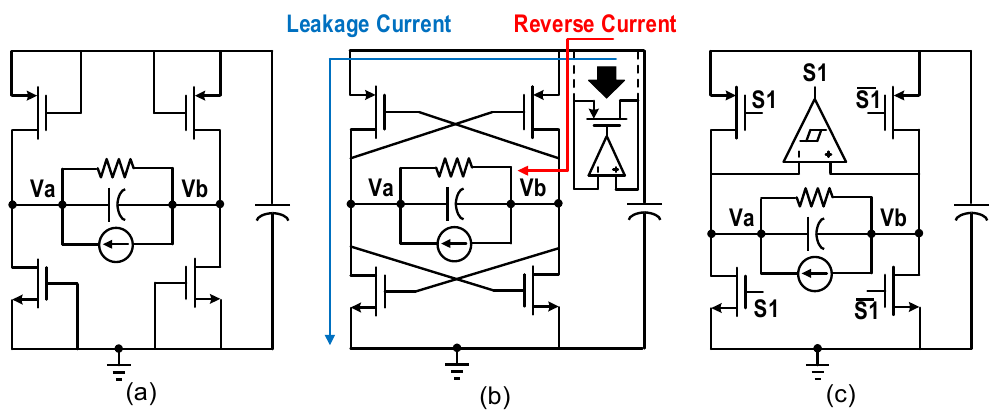
Figure 7. Structure diagrams of ( a ) diode-connected rectifier, ( b ) negative voltage converter, ( c ) extraction efficiency enhanced rectifier for the SECE.